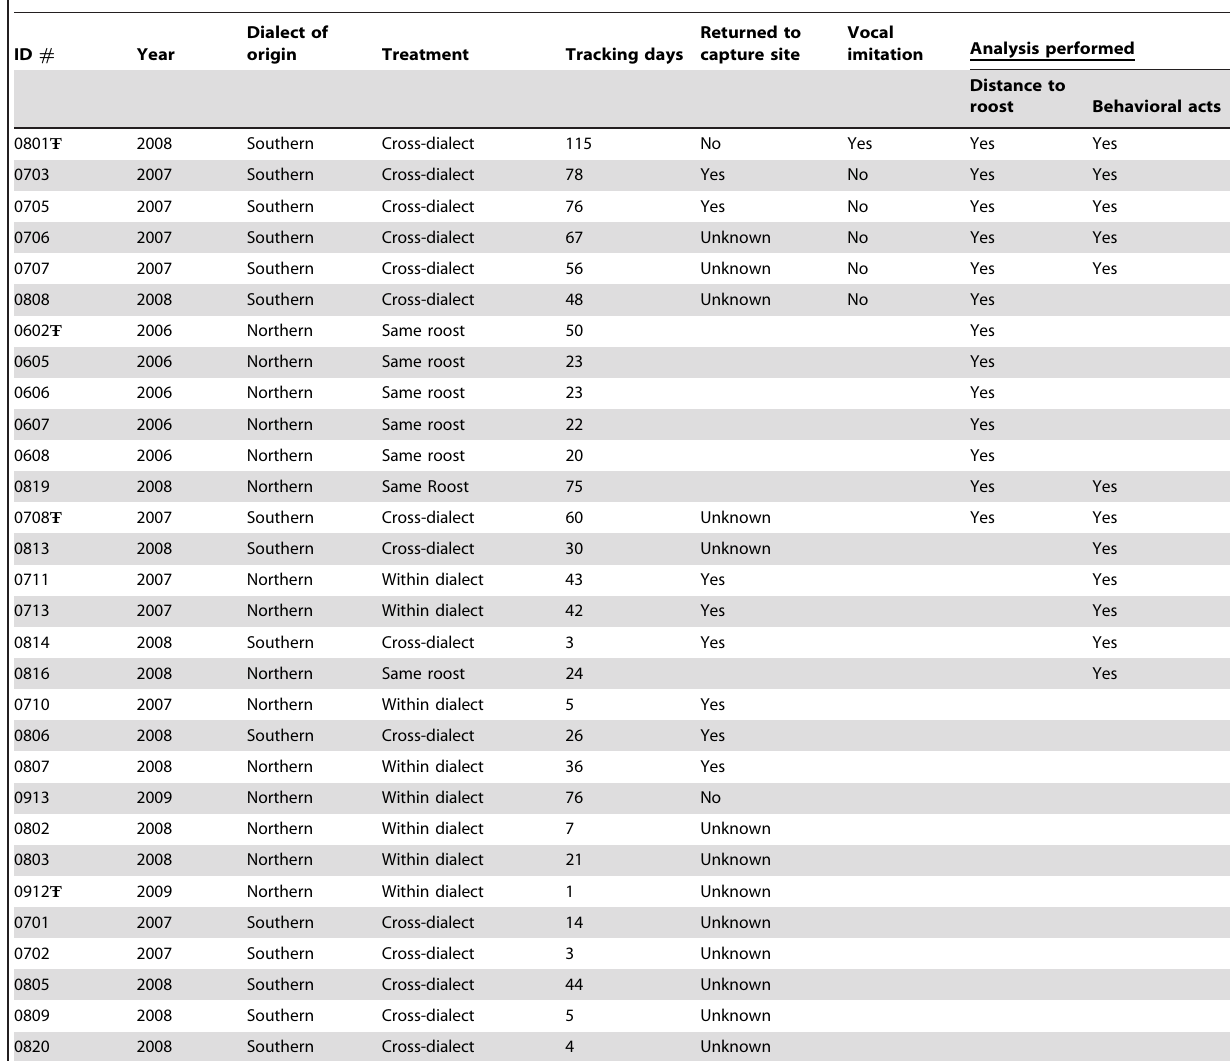
Table 1. Summary of captured yellow-naped amazons indicating analysis in which they were included.